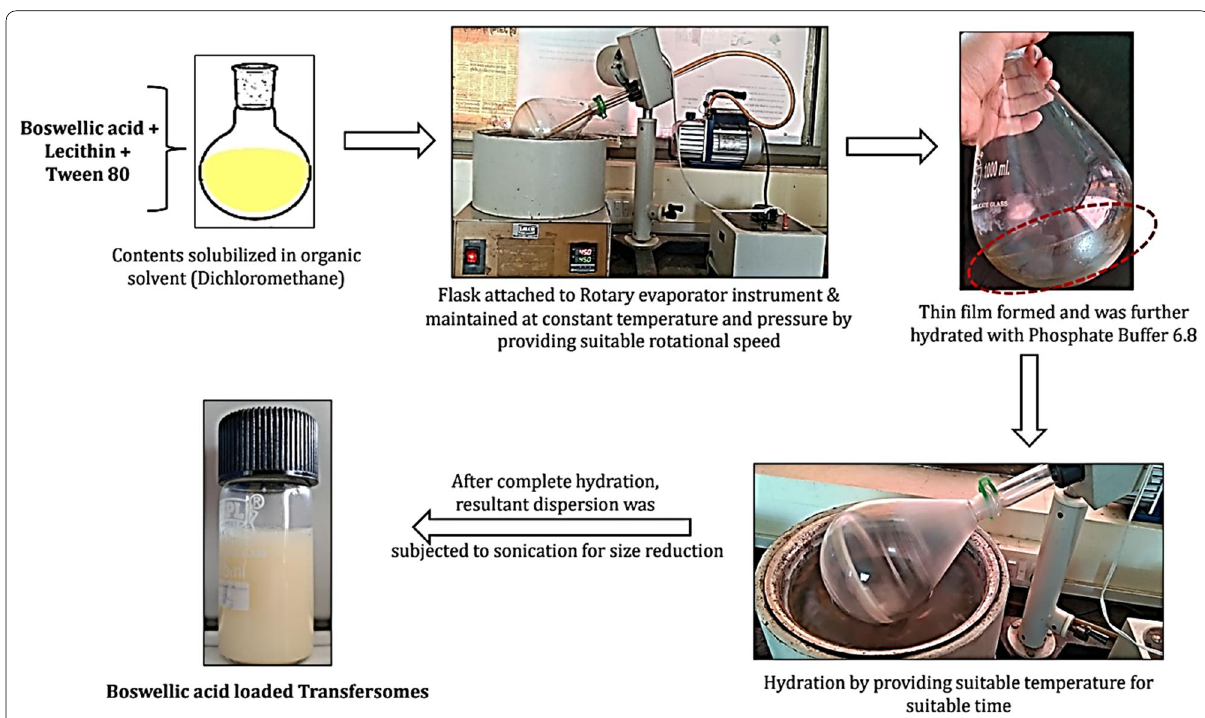
Fig. 1 Formulation methodology of transferosomes